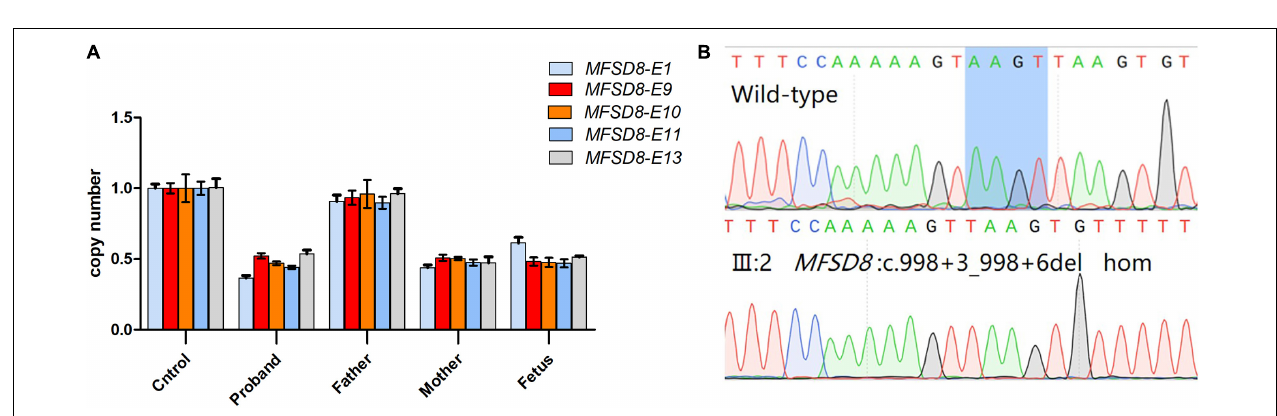
FIGURE 4 | Schematic diagram of alternative splicing isoforms. (A) Schematic presentation of MFSD8 splicing. The arrows above the diagram indicate the positions of the mutation c.998 + 3_998 + 6del of MFSD8. (B) Sanger sequencing analysis of the proband (III:1) showed exon skipping in the cDNA. (C) Schematic presentation of RDH12 splicing. The arrows above the diagram indicate the positions of the mutation c.343 + 1G > A of RDH12 . (D) Sanger sequencing analysis of the mother (II:2) showed an intron retention in the cDNA.